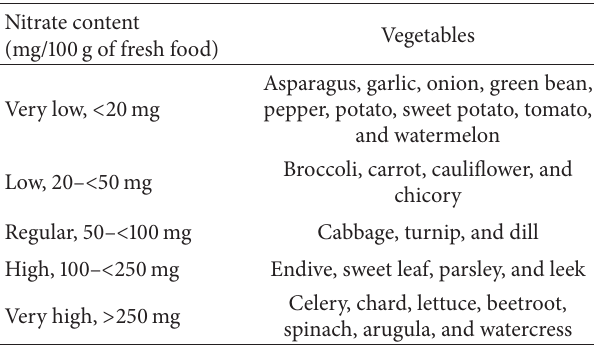
Table 1: Vegetables grouping according to the nitrate concentration